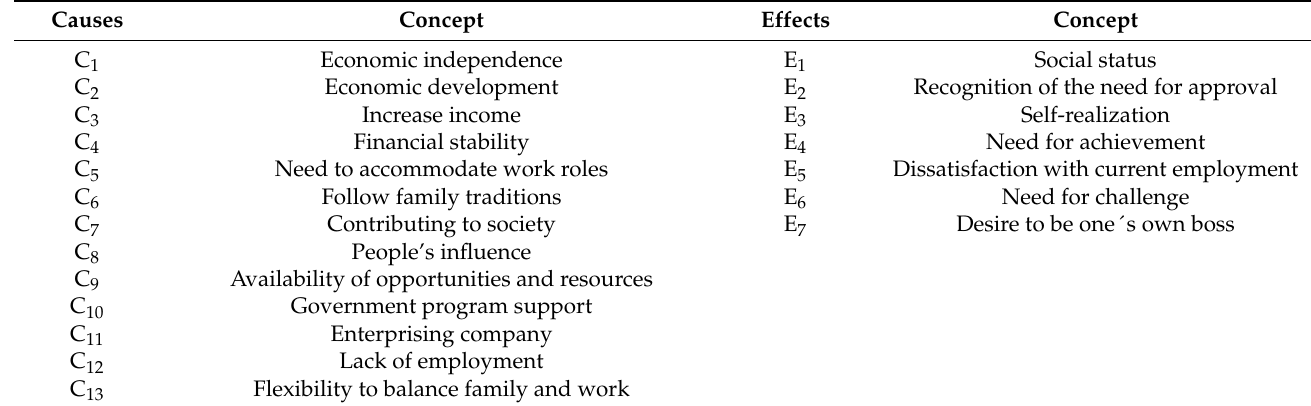
Table 5. Causes and effects in the study.